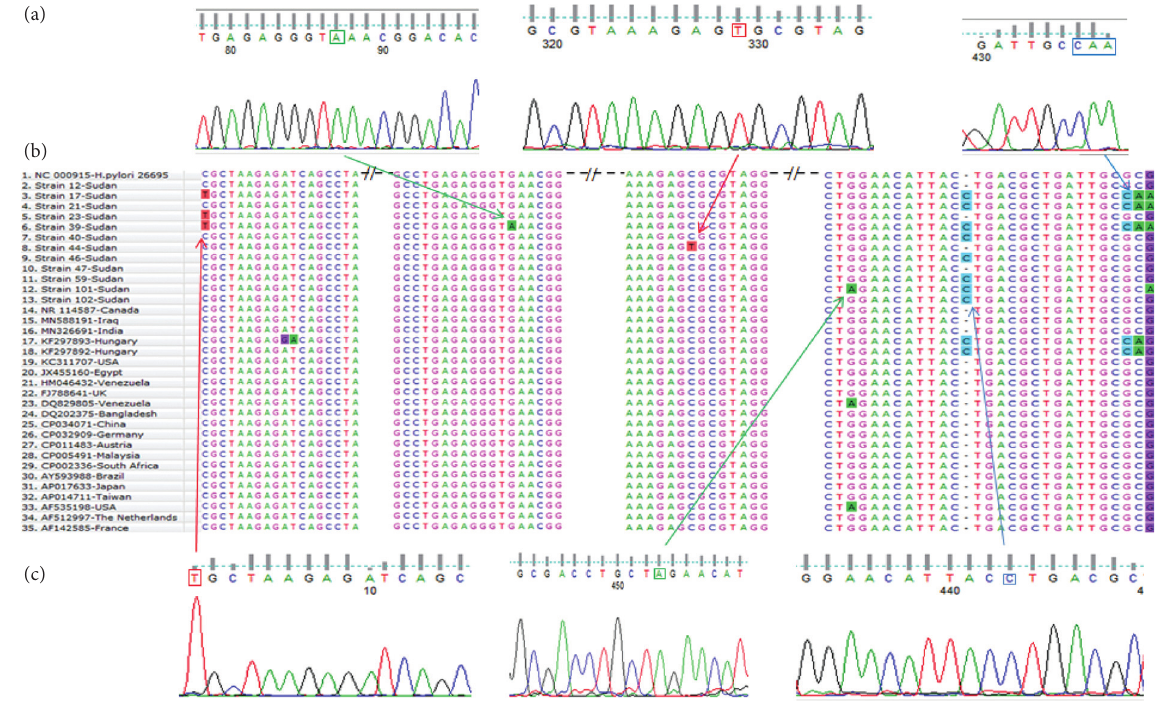
Figure 2: (a) and (c) Sequencing results of chromatograms using Finch TV software show nucleotide variations in the 16S rRNA gene of H. pylori illustrated by squares. (b) Multiple Sequence Alignment (MSA) of 16S rRNA sequences of 12 Sudanese H. pylori strains compared with the rrnA gene of H. pylori strain 26695 (NC_000915) and other selected strains obtained from GenBank databases using Clustal